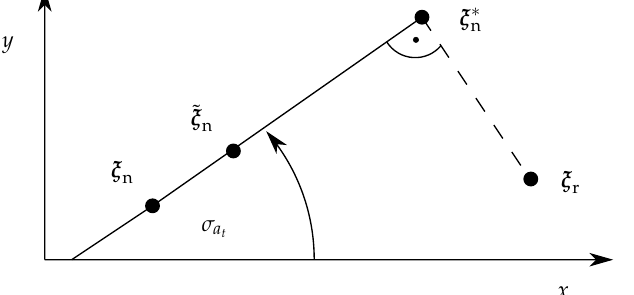
˜ ξ n and kick direction σ a t , any point n lying on the line can be